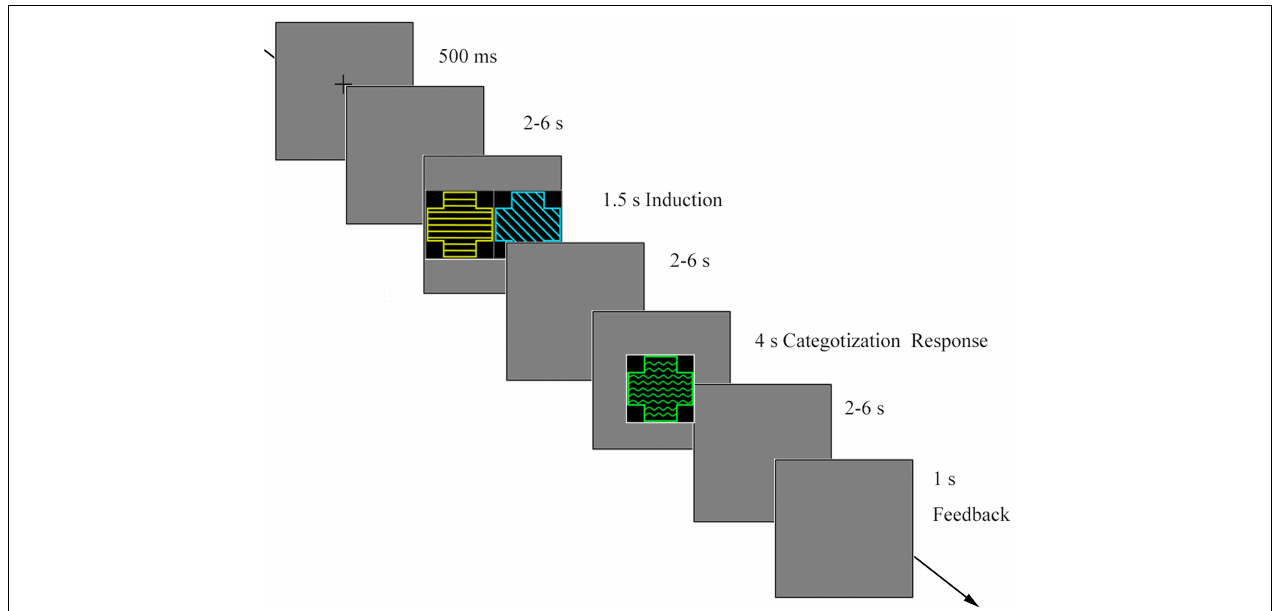
FIGURE 2 | The procedure of the category induction task.